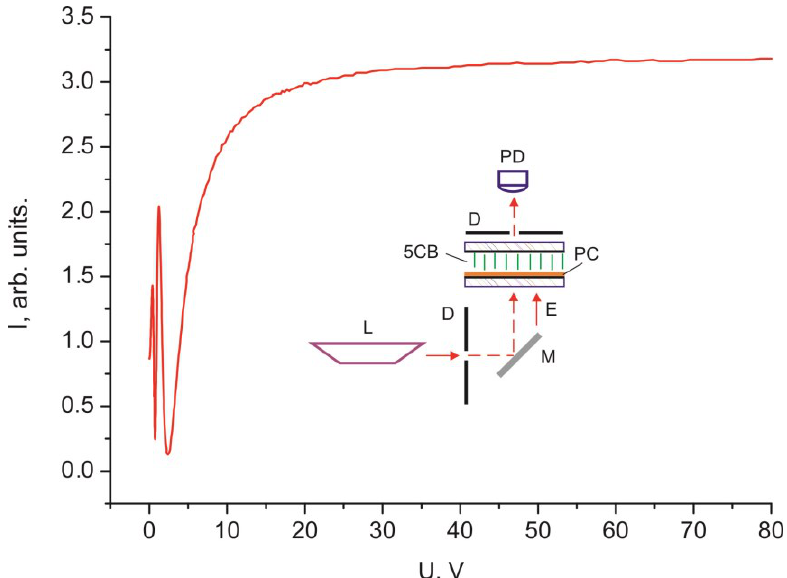
Figure 4. Voltage dependence of intensity I of monochromatic light passed through the 30 µm thick homeotropic 5CB layer with domains formed on the PC surface.